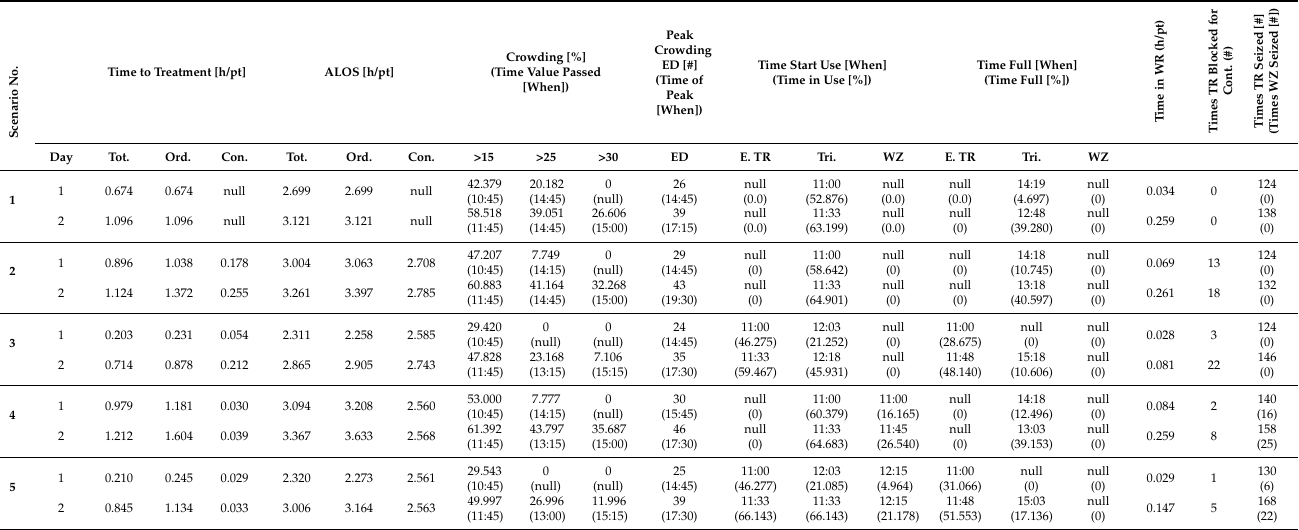
Table 4. Tabulated PF indicators for the simulation outputs of scenarios